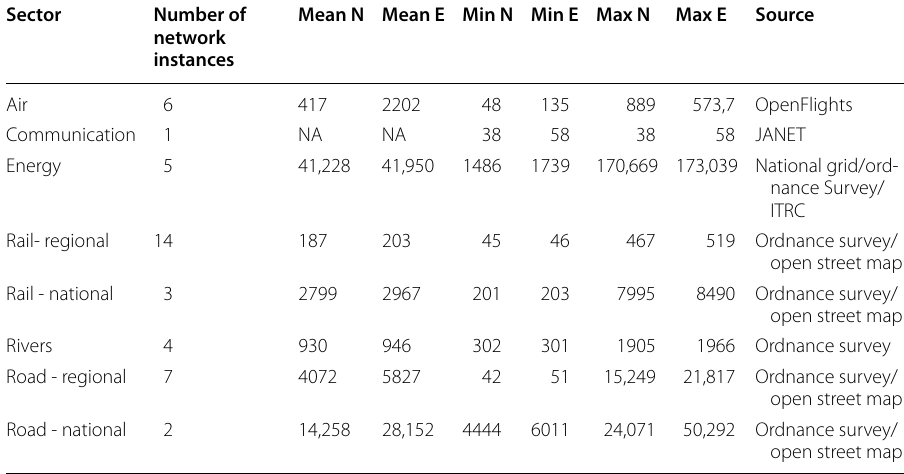
Table 1 Summary of the six infrastructure sectors which constitute the suite of networks